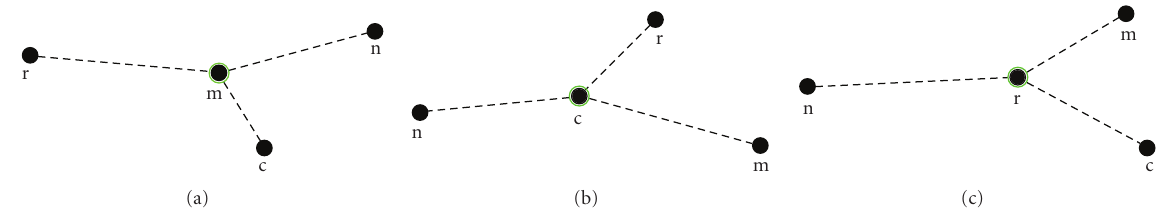
Figure 4: (a) KeyGraphs for achievers, (b) socializers, and (c) explorers generated from the given sample data sets, where m (interaction to a mission master), c (chat), and r (interaction to a remote object) are the keywords in (a), (b), and (c), respectively.